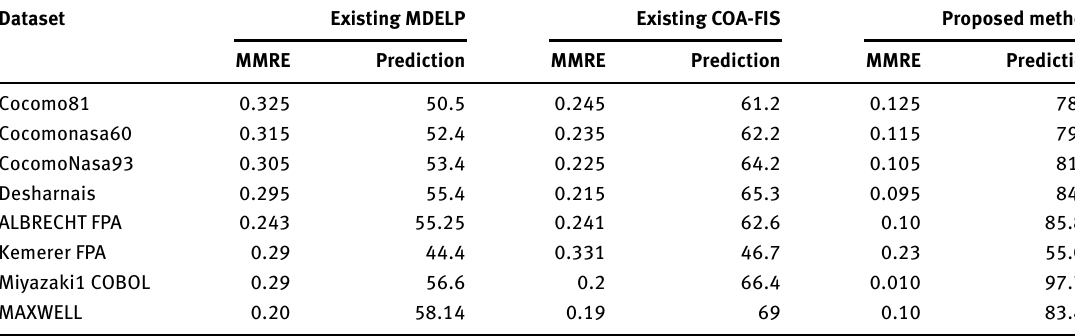
Table 6: Comparison of Proposed Work with Two Existing Methods.